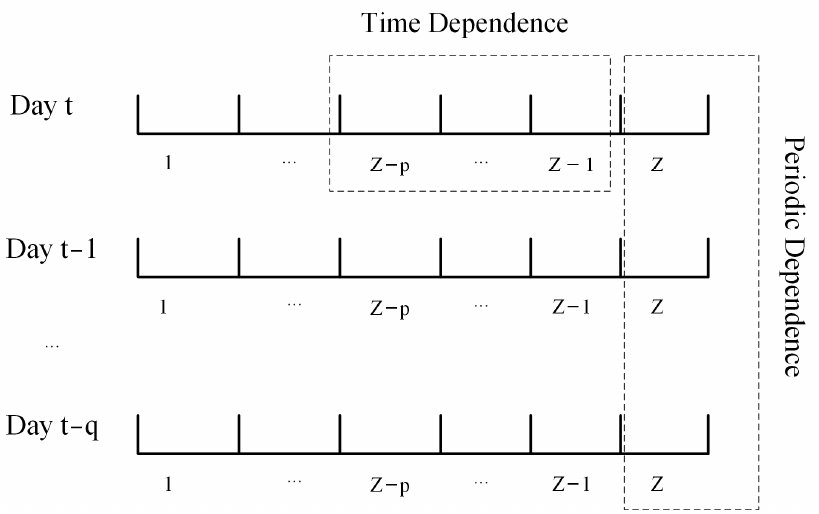
Figure 4. Two-channel training data.